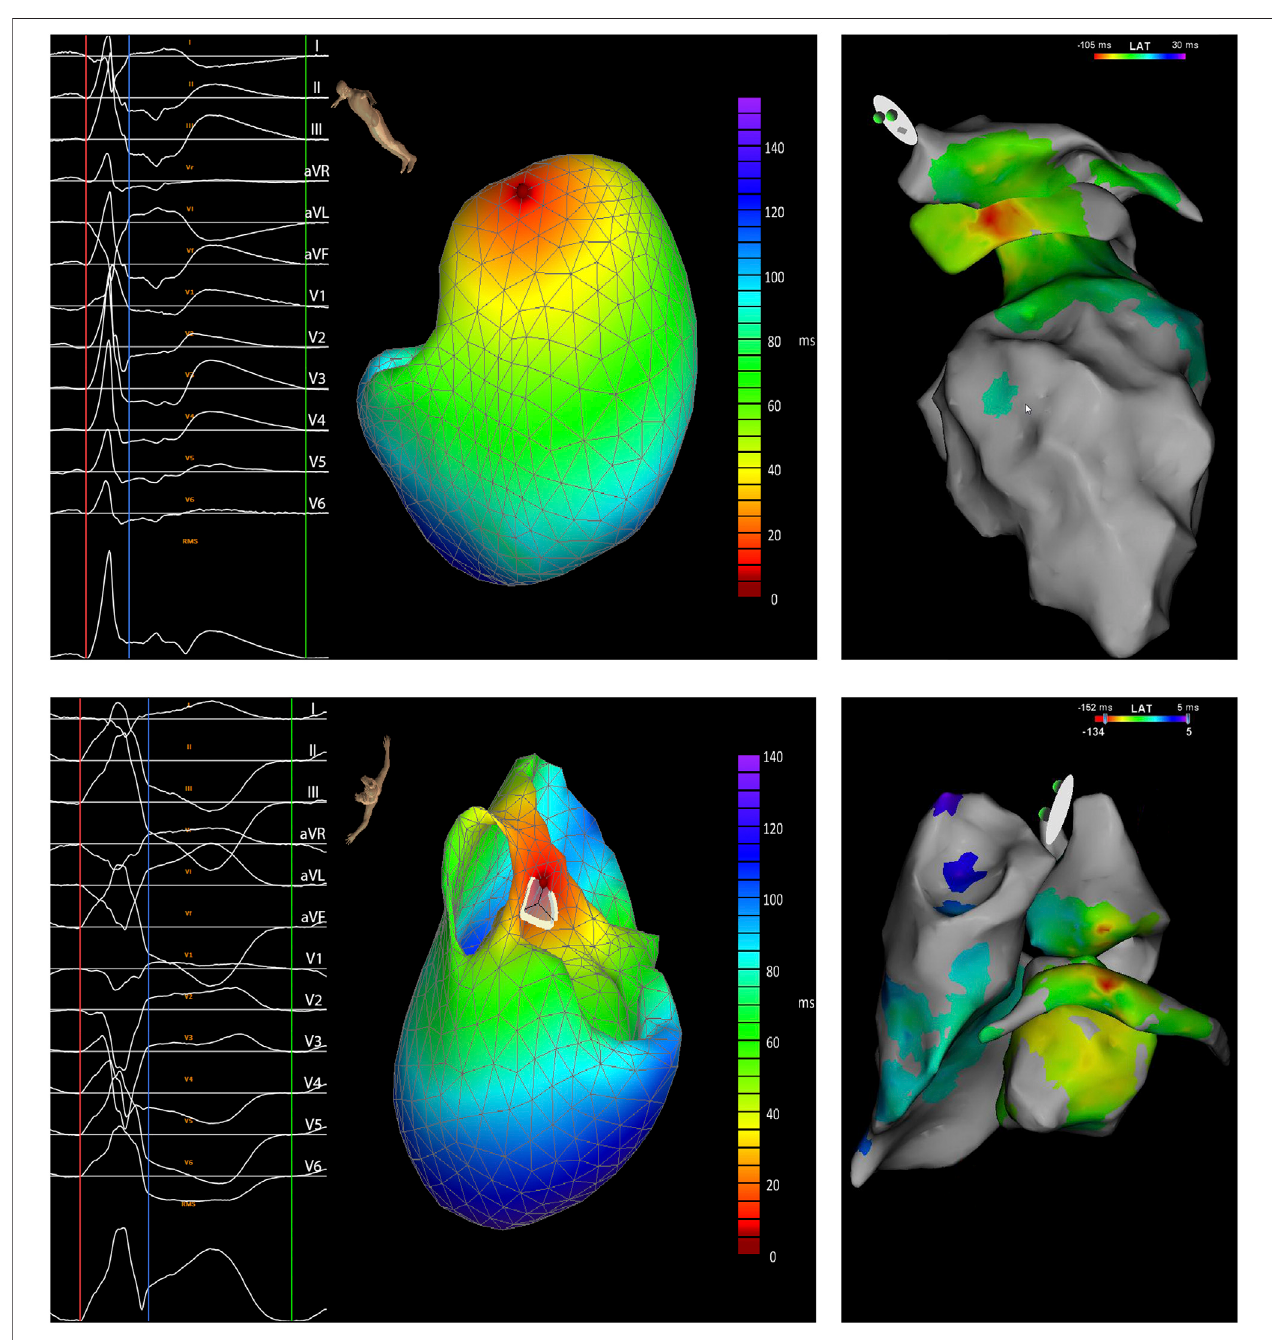
FIGURE 1 | Two examples of predicted locations of a premature ventricular complex (PVC) by the VIVO system showing the analyzed PVC with the onset of the QRScomplexmarkedbyaredandtheendbyabluelineandtriangulatedheartmodel(left)andtheelectro-anatomicalmapwiththelocalventricularactivationtime(LAT) ofthemorphologicallysamePVC (right). Theexampleat thetopshows agoodcorrelation withtheventricular activationmeasured from thegreatcardiac vein preceding theactivationmeasuredtheleftatrialappendageandventricle.ThePVCwassuccessfullytreatedwithradio-frequentenergyapplicationsfromtheleftventricleand great cardiac vein (patient 22). The example at the bottom shows the absence of a good correlation between the VIVO map (predicted location of origin being the right coronarycusp)and theelectro-anatomicalmap withtheventricularactivationrecorded fromthegreatcardiac vein preceding theactivationmeasured fromthe rightand left ventricle and coronary cusps. Ablation from great cardiac vein and left ventricle suppressed the PVCs but applications from the left coronary cusp were ineffective. After the procedure, the remaining PVCs disappeared and have not recurred during follow-up (patient 46).